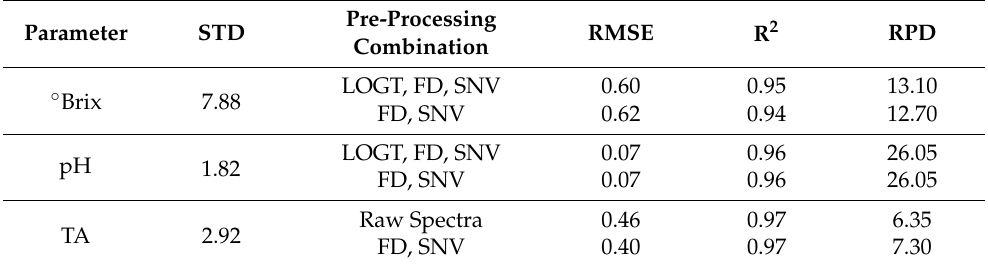
Table 2. PLSR accuracy on grape parameters by means of the best combinations of pre-processing techniques in the season 2019. Parameter STD